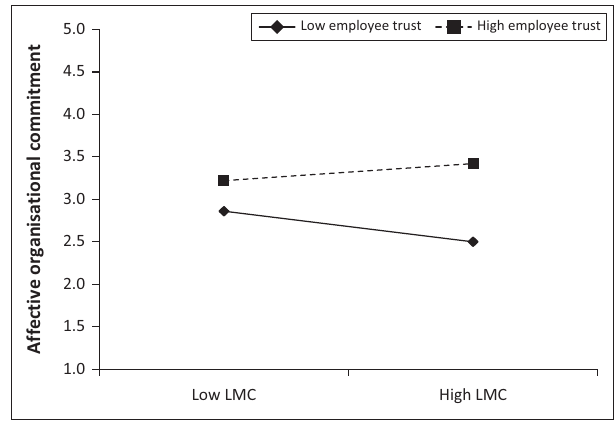
LMC, line manager communications. FIGURE 3: The interaction between line manager communication and employee trust to influence affective organisational